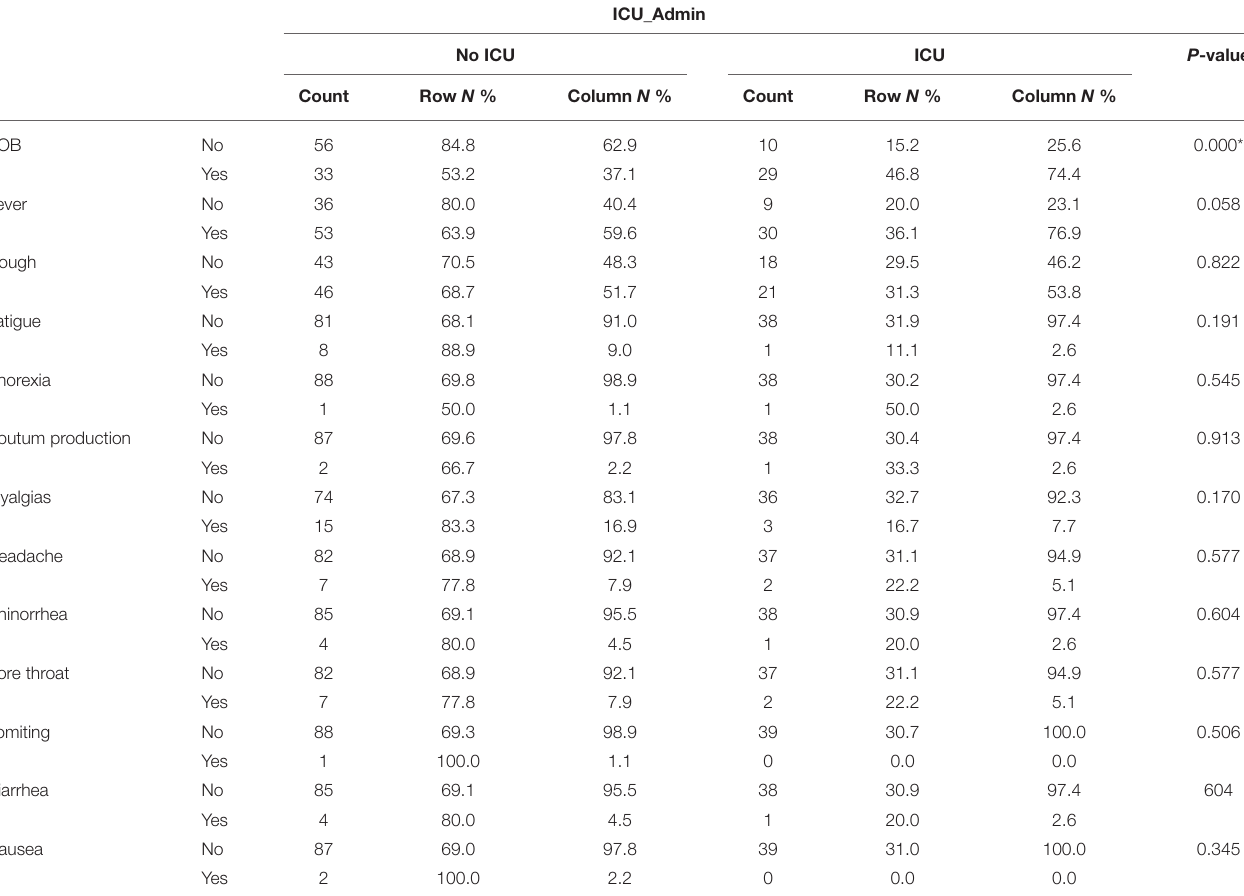
TABLE 2 | Chief presentation in the training